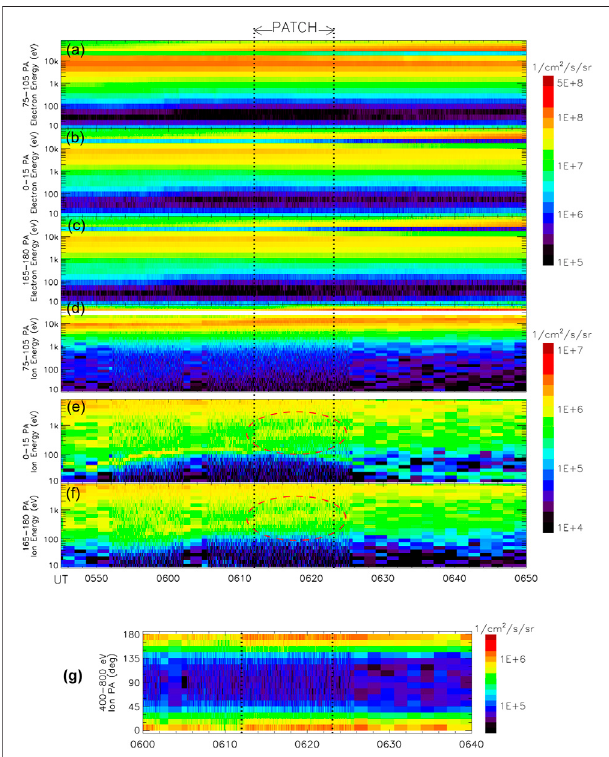
FIGURE3| Panels (A – C) showtheelectron energy fl uxspectrograms in perpendicular, parallel, and anti-parallel directions, respectively, observed by THEMIS-E. In each panel we have combined the ESA and SST data (the SST fl ux is multiplied by 40 for better vision). Panels (D – F) show the ion energy fl ux spectrograms in perpendicular, parallel, and anti-parallel directions, respectively. The energy range in panels (E) and (F) is adjusted to better focus on the low-energy ions of interest. Panel (G) shows the pitch- angle spectrogram of 400 – 800 eV ions.